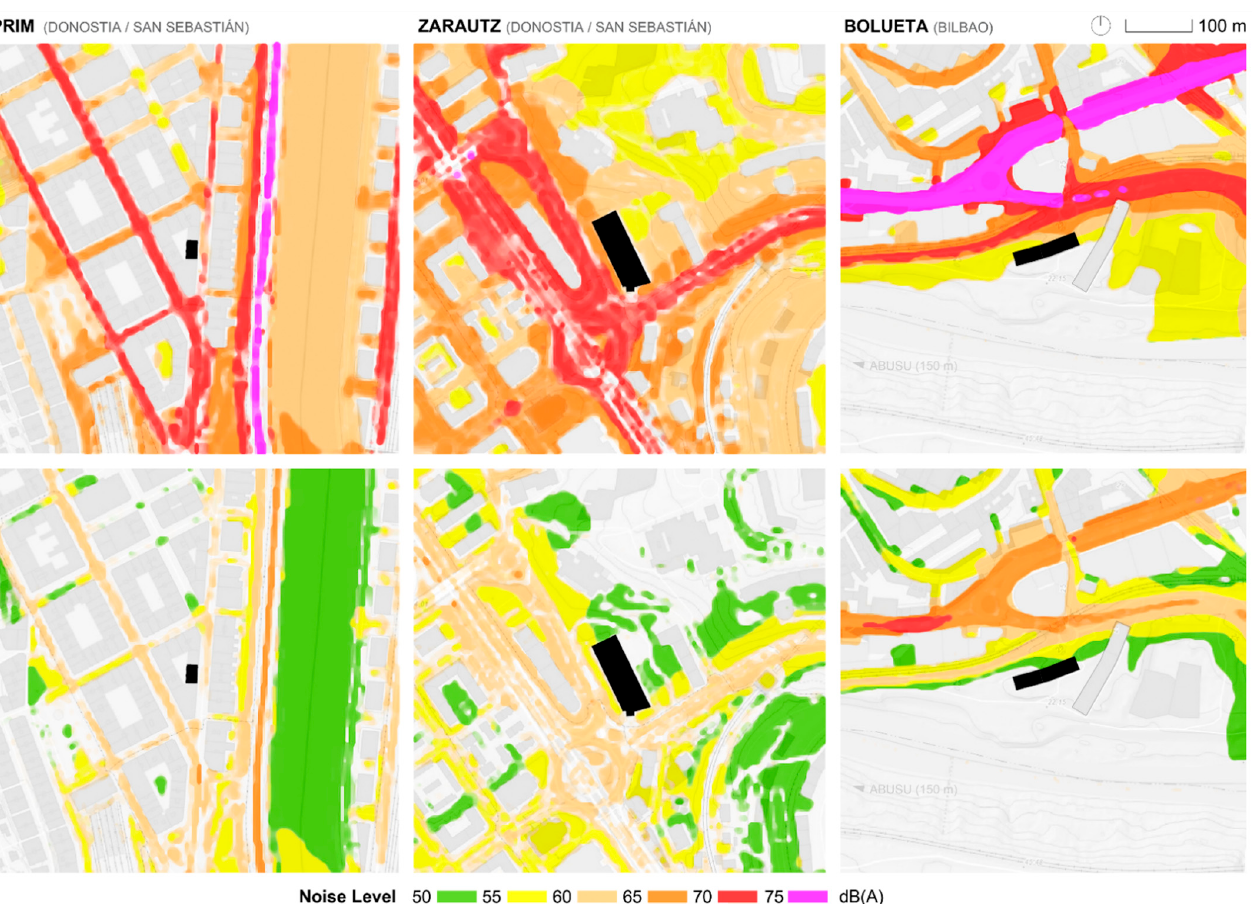
Figure 8. Complete daytime Lden ( top ) and night-time Ln ( bottom ) noise levels in the surroundings of the studied buildings, according to the Donostia-San Sebastián and Bilbao local noise maps. Source: authors, adapted from [79] and [80].